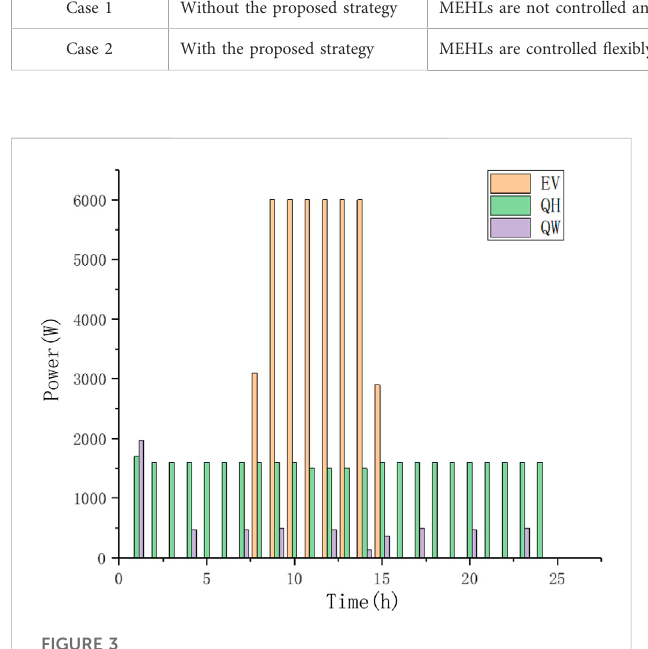
FIGURE 3 The basic energy demand distribution of house residents.